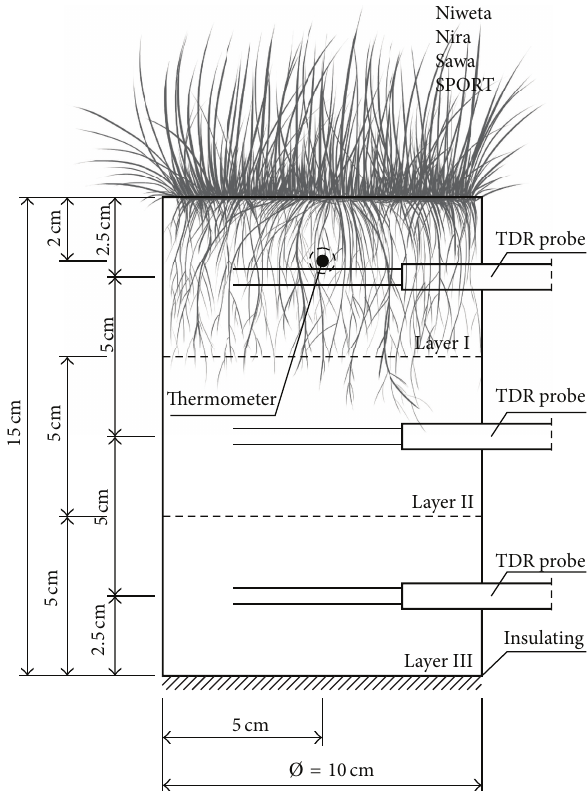
Figure 2: Schematic diagram of the